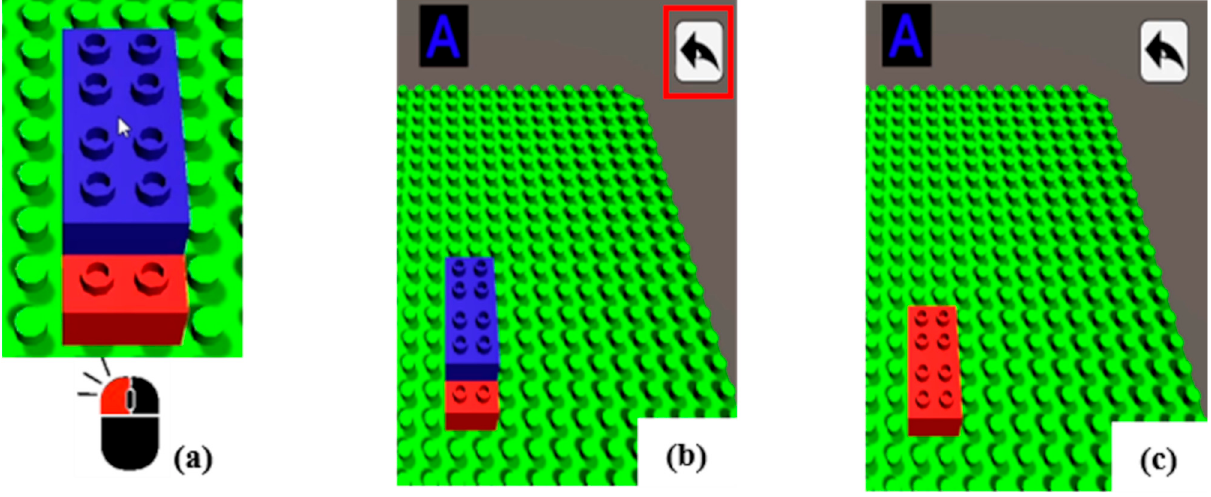
Figure 5. Assembling and disassembling metaphors: ( a ) the picked blue LEGO brick is attached to the placed red brick in a way different from that required by the instruction; ( b ) an “undo” button allows the user to delete the last blue LEGO brick that they wrongly placed; ( c ) the brick that needs to be disassembled is instantly removed after clicking on the “undo” button.